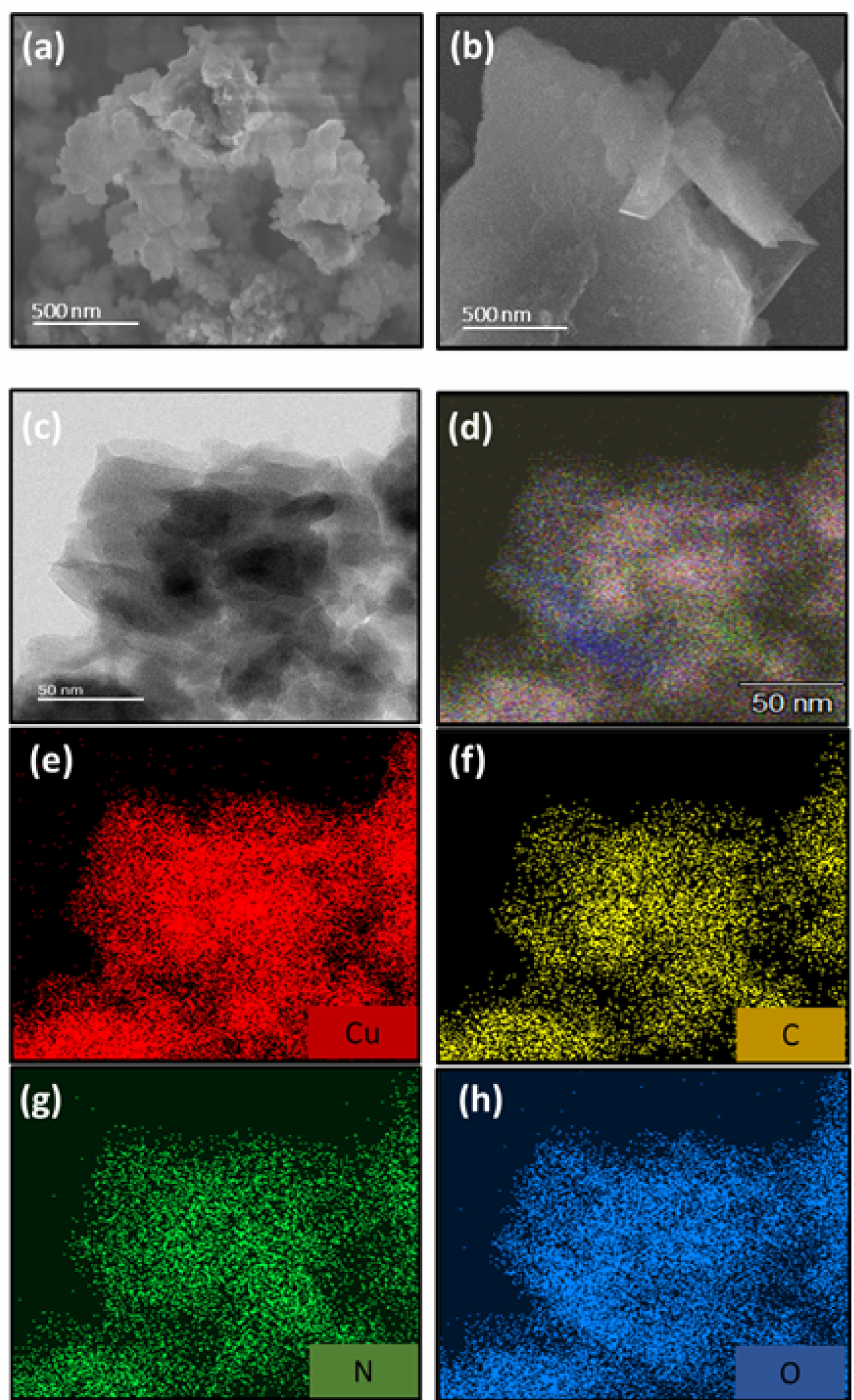
Figure 1. ( a , b ) SEM images of the Cu-THQ MOF and Cu-THQ-EFG, respectively; ( c ) TEM images of Cu-THQ-EFG; ( d – h ) the corresponding element mapping results of Cu, C, N and O in Cu-THQ-EFG. The XRD data of Cu-THQ-EFG displays peaks at 8.0, 15.9 and 30.2 ◦ , corresponding to the planes of (100/020), (220) and (002), respectively, which matches well with the XRD patterns (Figure 2a) of pristine MOF and Cu-THQ-GO, moreover, they all agrees well with the XRD peaks reported in literature [28]. The strong peak at 27 ◦ belongs to the EFG substrate (Figure S5). This further demonstrates that MOF is successfully deposited on the EFG surface. Similarly, the weaken XRD peaks at around 10 ◦ and 30 ◦ of